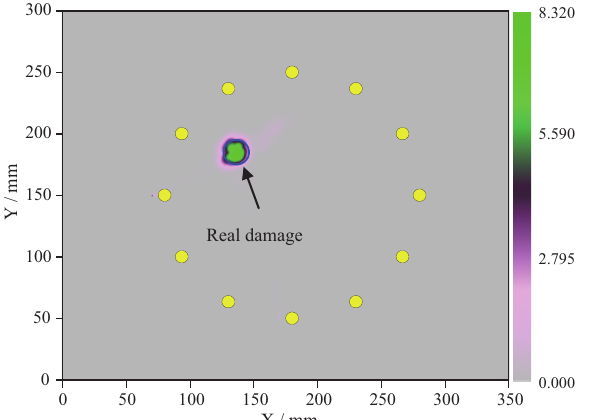
Fig. 9. Damage image of the composite laminate.